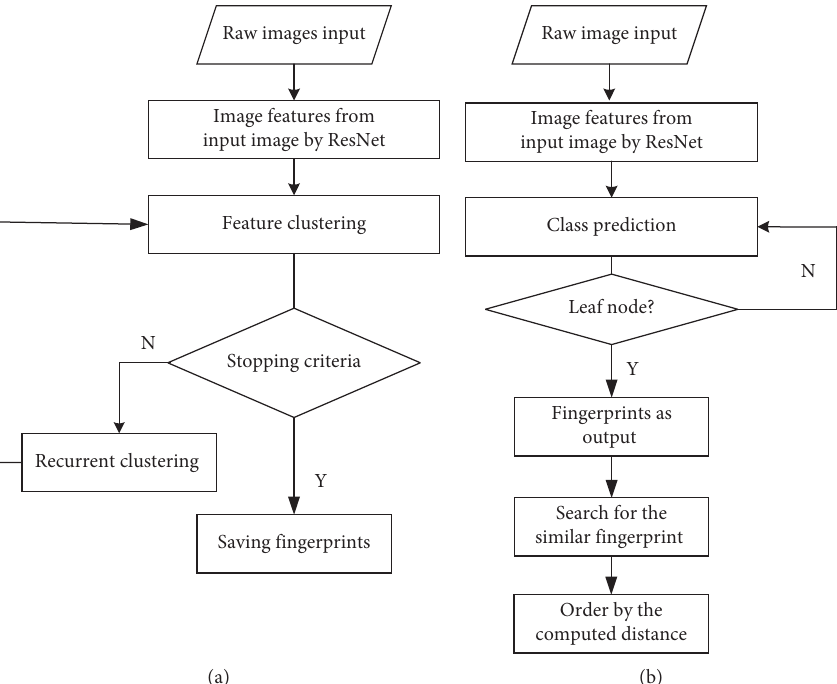
Figure 3: Flowchart of training and searching steps for tree-based algorithm. (a) Flowchart of training steps for tree-based algorithm. (b) Flowchart of searching steps for tree-based